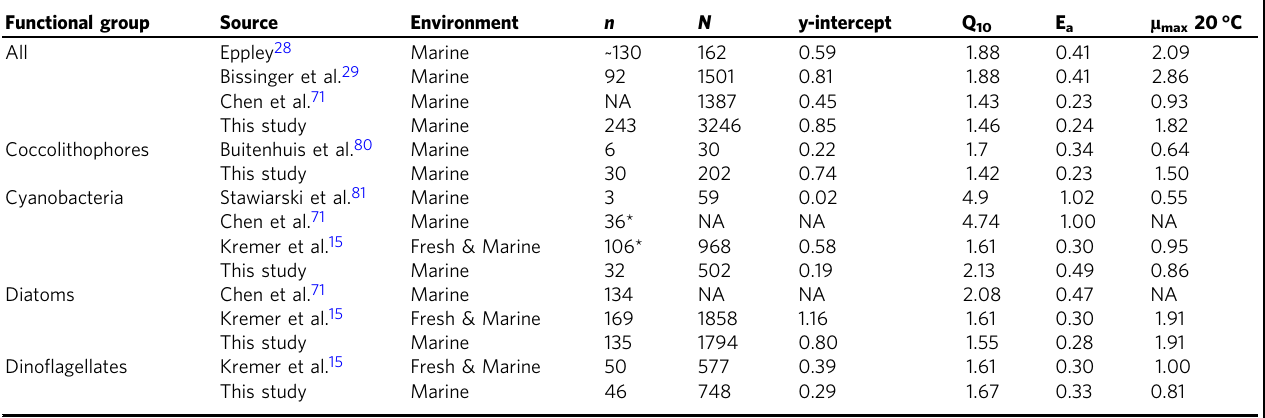
Table 1 Functional group thermal equation coef fi cients and dependencies. Functional